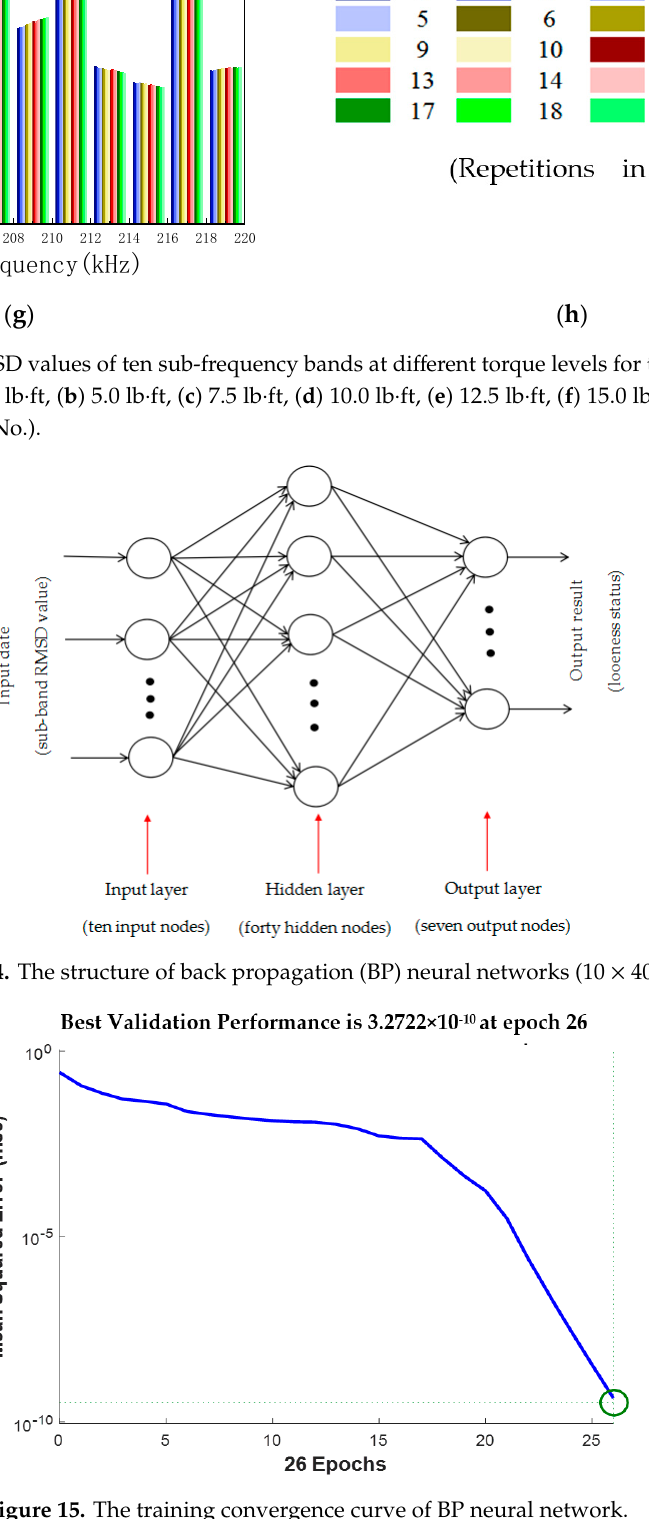
Figure 15. The training convergence curve of BP neural network.